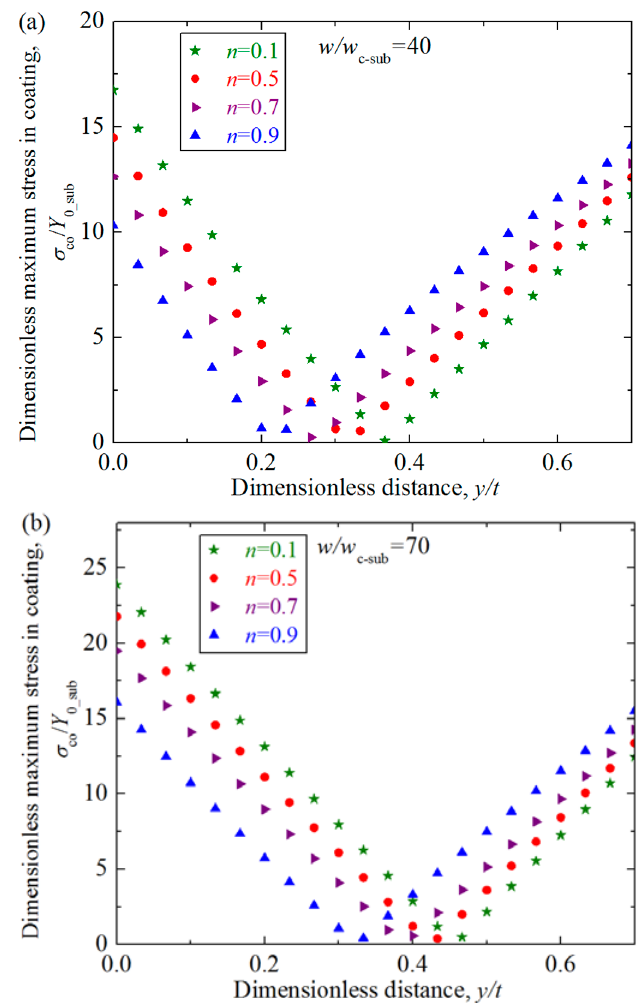
Figure 10. The stress distribution σ co /Y 0_sub in the coating along the axis of symmetry in the coating near the low stress zone at the dimensionless interferences w / w c_sub = 40 and 70 for n = 0.1, 0.5, 0.7, 0.9 cases when dimensionless coating thickness t/R = 0.01, Young’s modulus ratios E co /E su = 4. ( a ) w / w c_sub = 40; ( b ) w / w c_sub = 70.